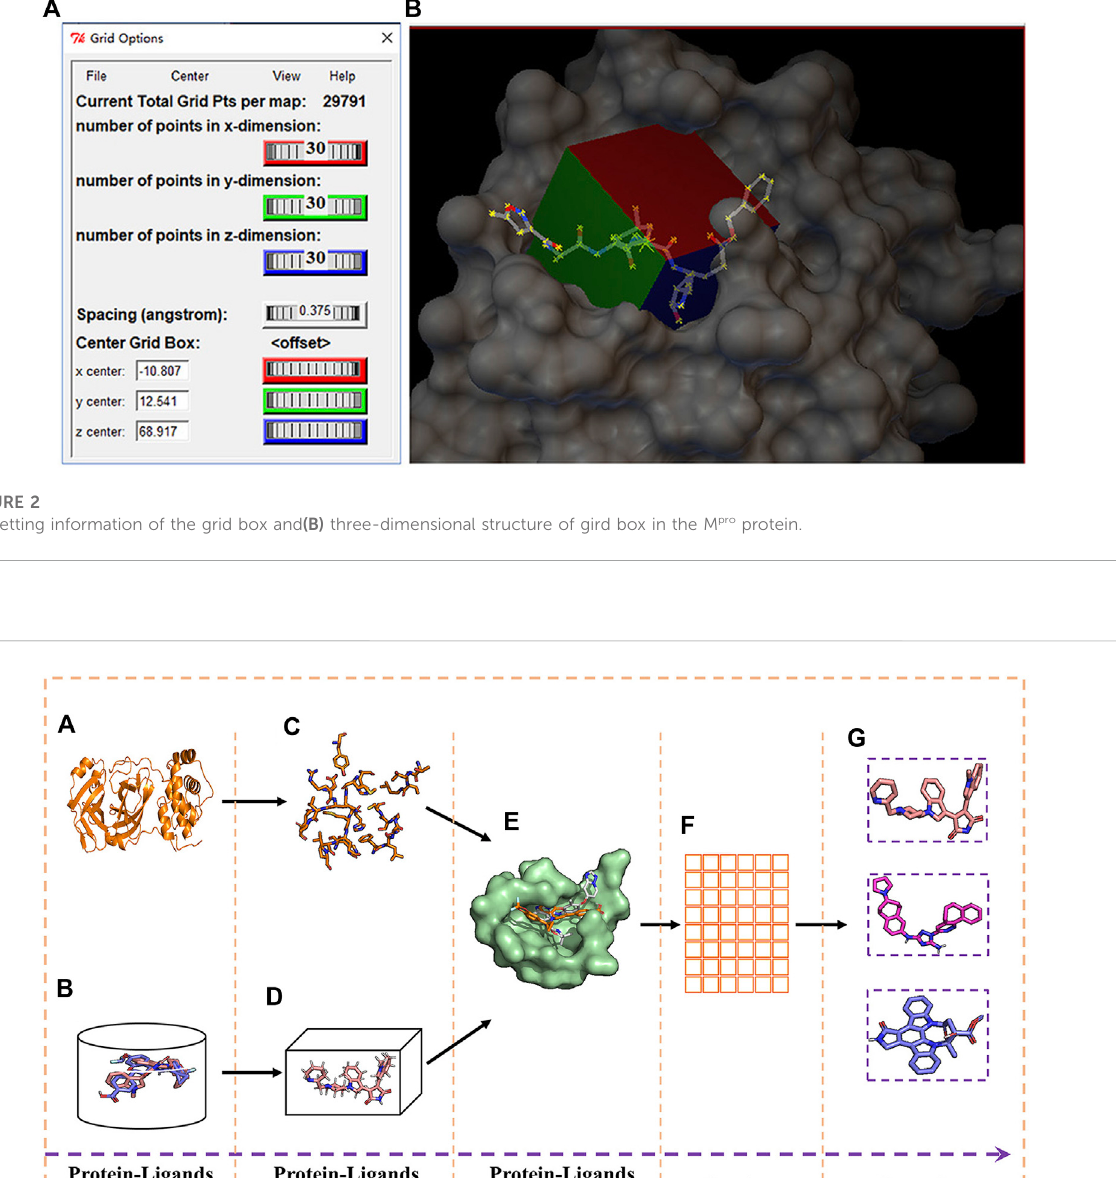
ligand molecule. It was used to calculate the free energy score of M pro with different conformations of each ligand. implementing a speci fi c Python script program. The optimal docking score of M pro with the N3 inhibitor was used as a reference standard for the analysis and screening to establish a